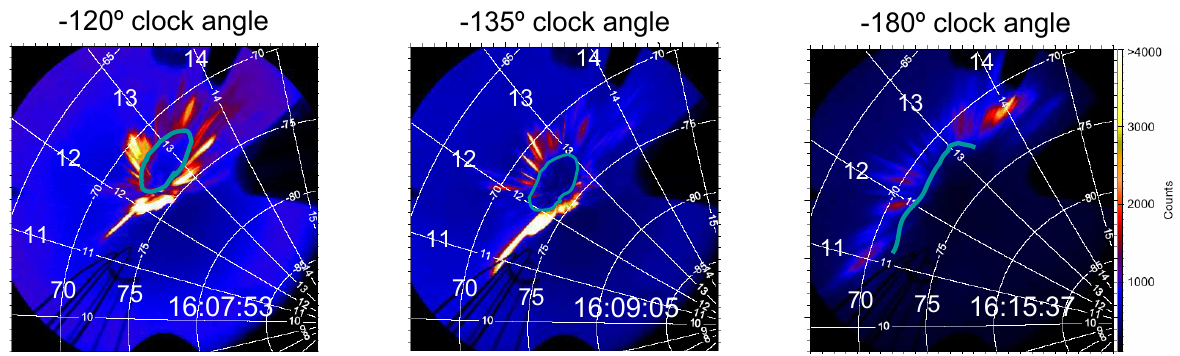
Fig. 16. Three 557.7nm images for clock angles of –120 ◦ , –135 ◦ , and –180 ◦ showing movement of the gap in emissions similar to the movement of the cusp depression in Fig. 15. The amplitude scale for the emissions is half that used in the other 557.7nm